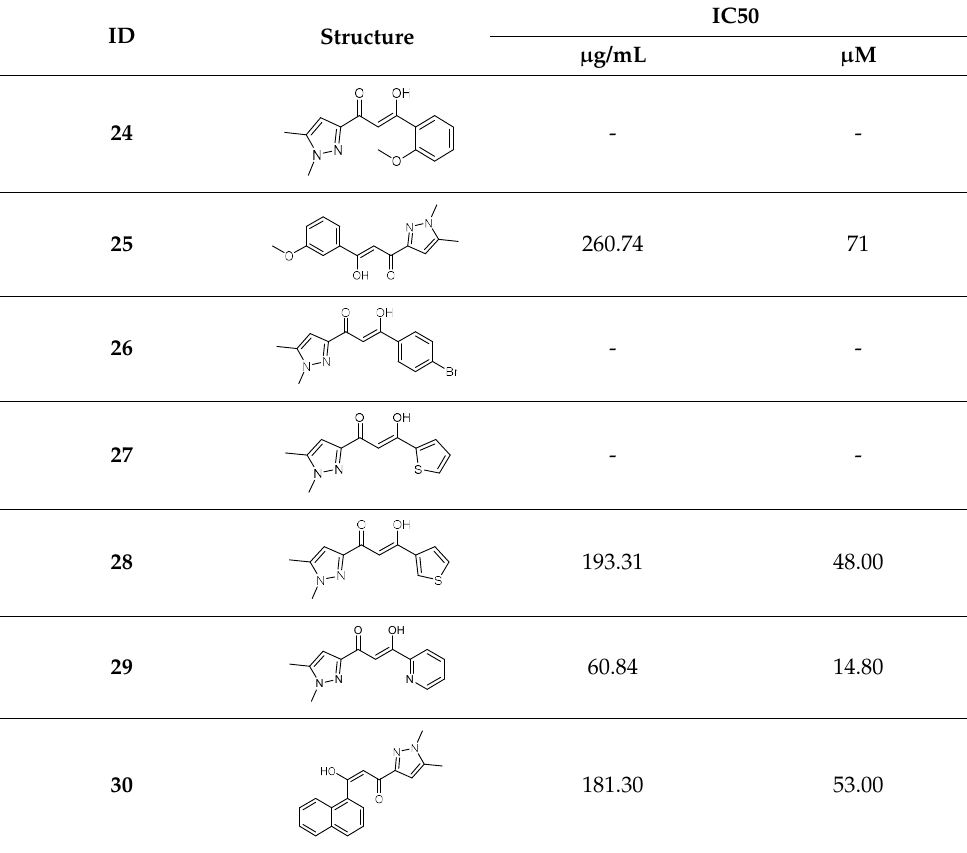
IC50 µ g/mL µ M